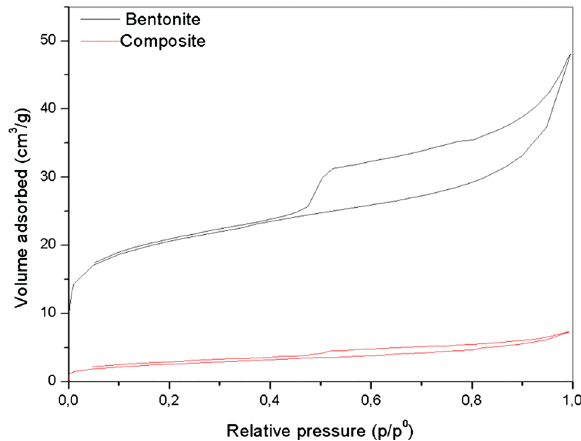
Fig. 1 N 2 adsorption–desorption isotherms of bentonite and compos- ite